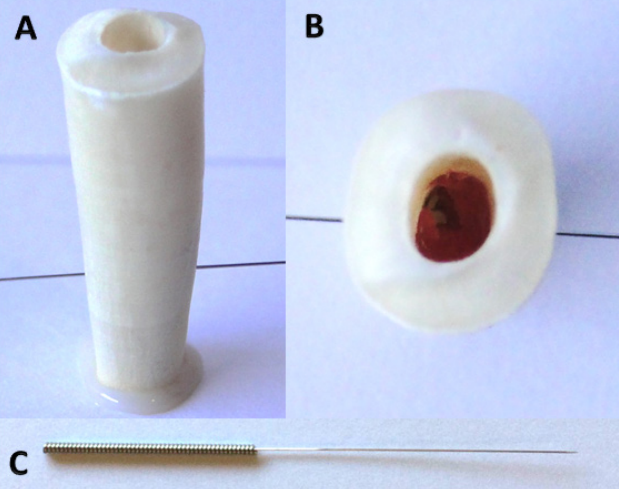
Fig.1. Image of pulp tissue fragment fixed inside the root canal: A (coronal view of the tooth), B (axial view of the tooth), and C (surgical steel needle). Before the solution agitation protocol inside the root canal, the endodontic instrument for the manual-mechanical agitation and the sonic and ultrasonic tips were calibrated on 8 mm from the root